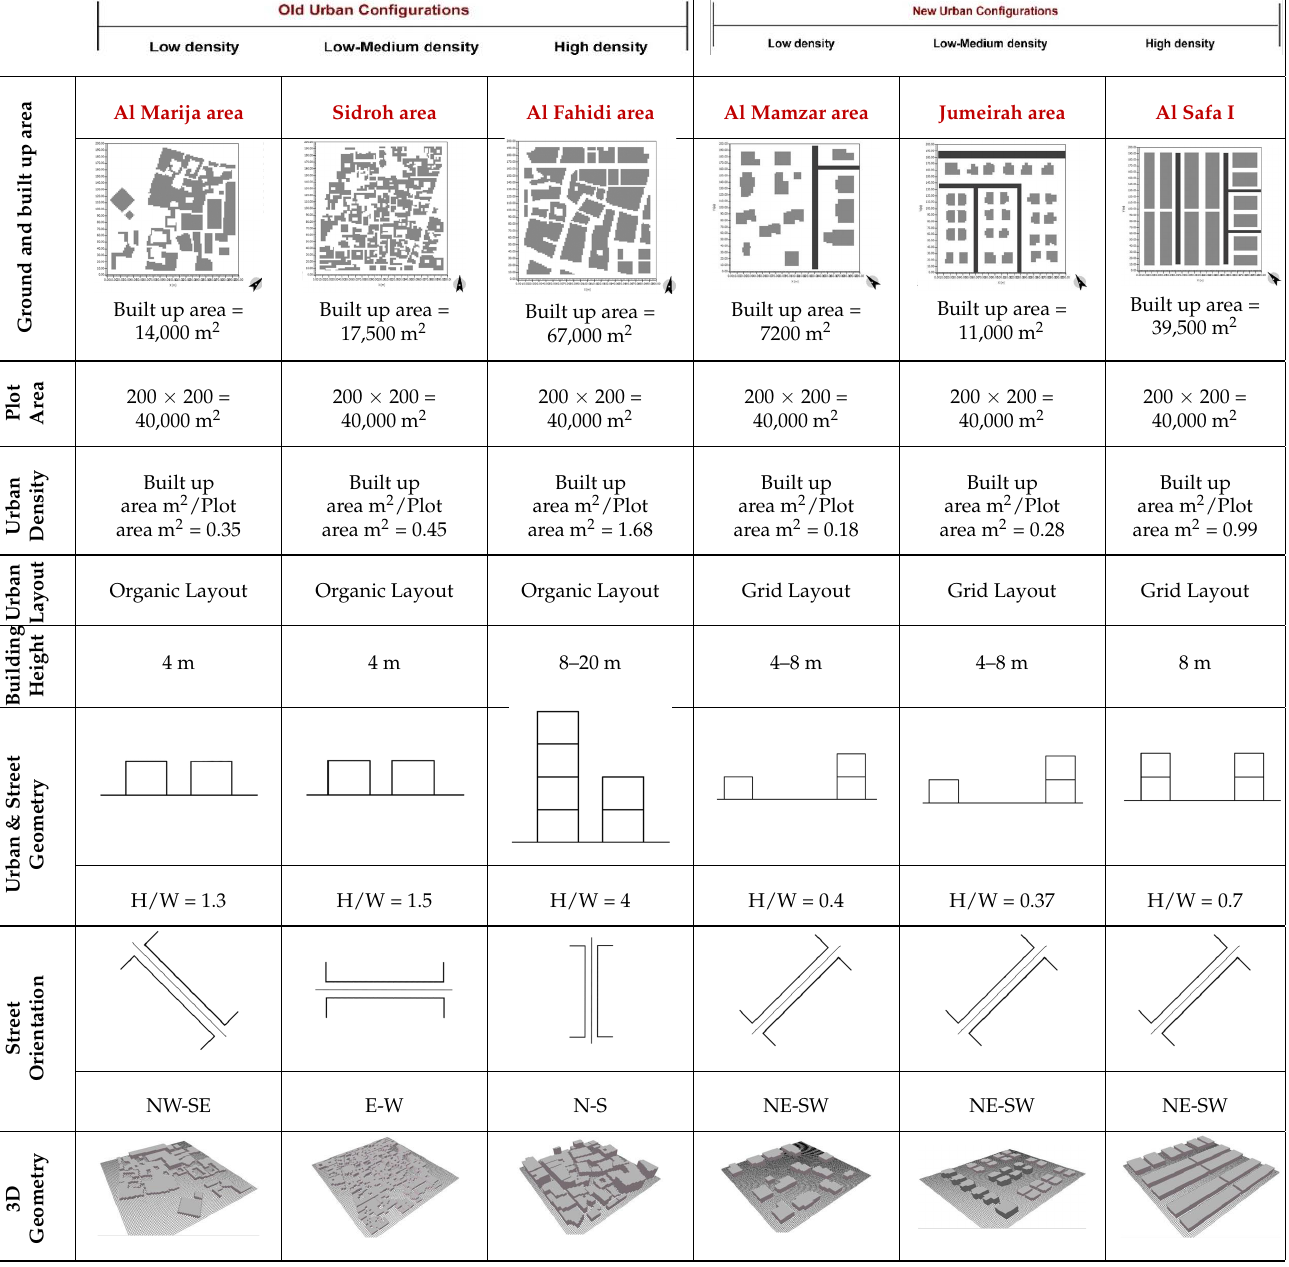
Table 5. Urban sites characteristics (author), ground and 3d geometry images generated by (ENVI-met).